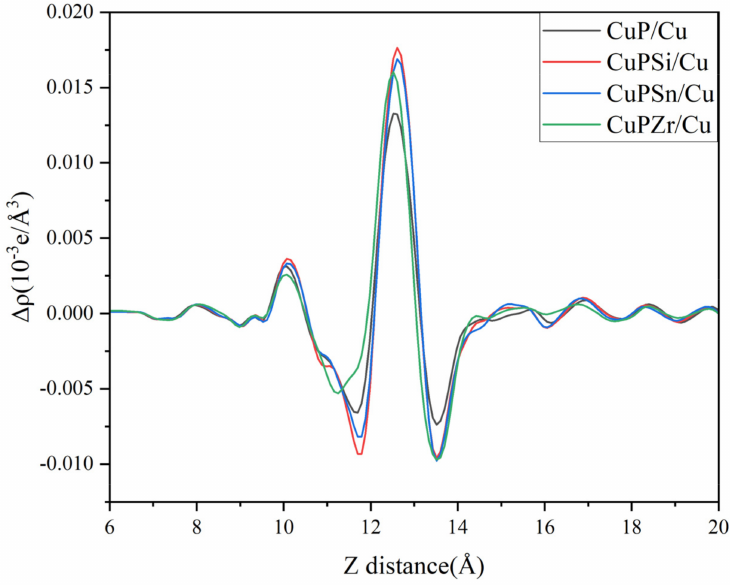
Figure 9. The plane-average electron difference of CuP-X/interface.